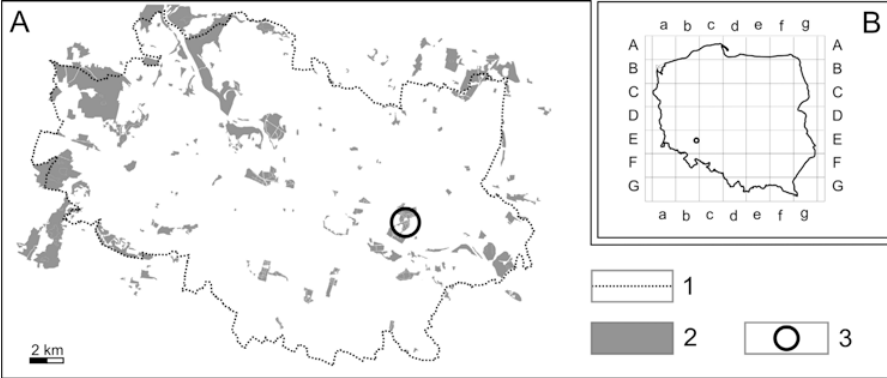
Fig. 1. The location of the Chalciporus rubinus site in Wrocław (a) and poland (B; based on a 100 km aTpOL grid); 1 – urban boundary, 2 – municipal forests and parks, 3 – locality of the